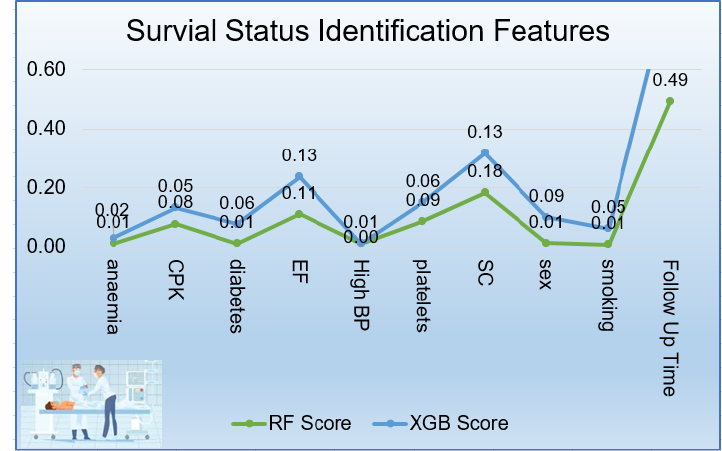
Figure 12. Patient Survival